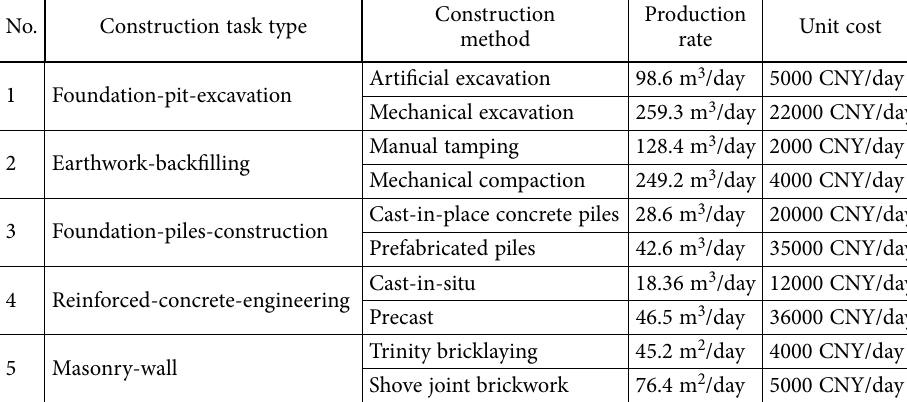
Table 4. The production rate and unit cost of construction method